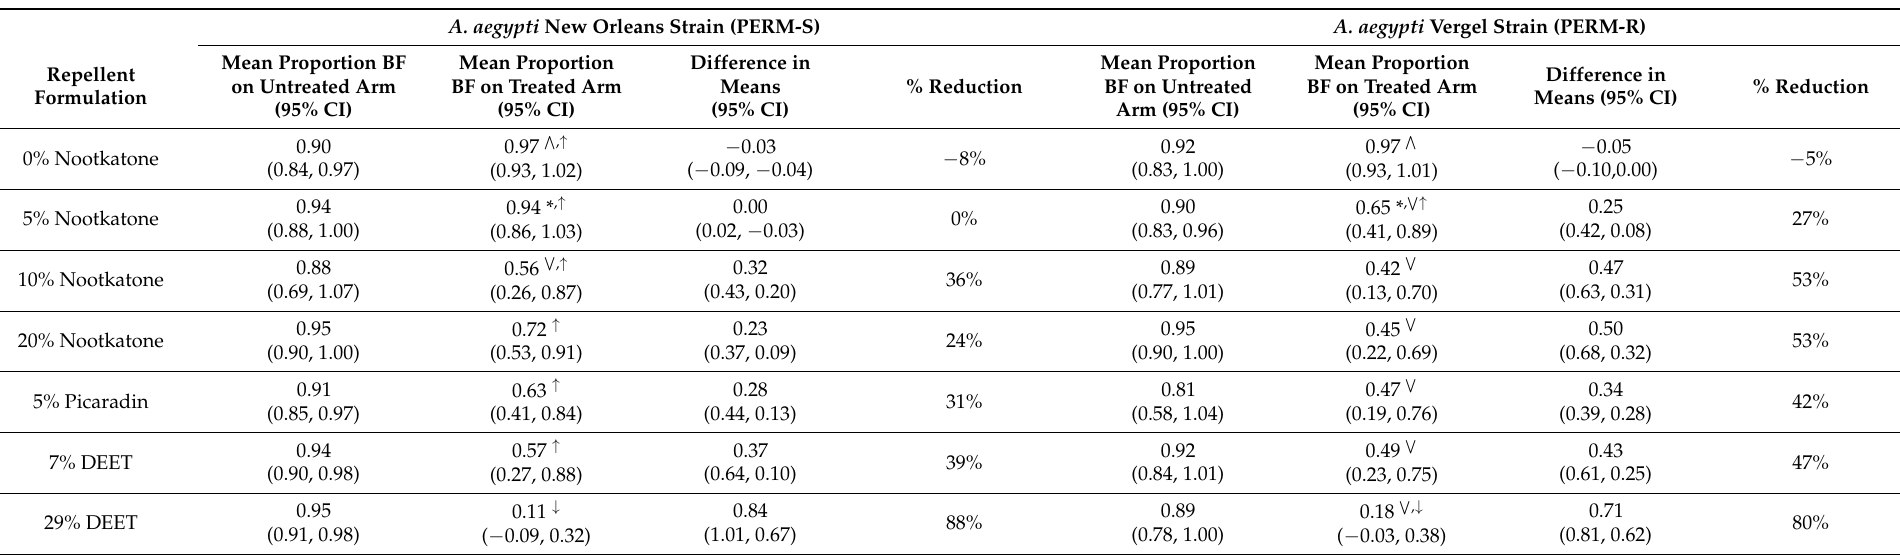
Table 4. Inhibition of A. aegypti blood-feeding in RIBB assay by tested